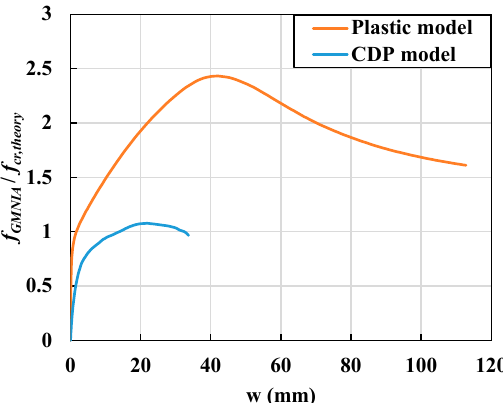
Figure 20. Relationship between normalized local buckling strength and slenderness ratio under the fixed support condition when λ f = 55.